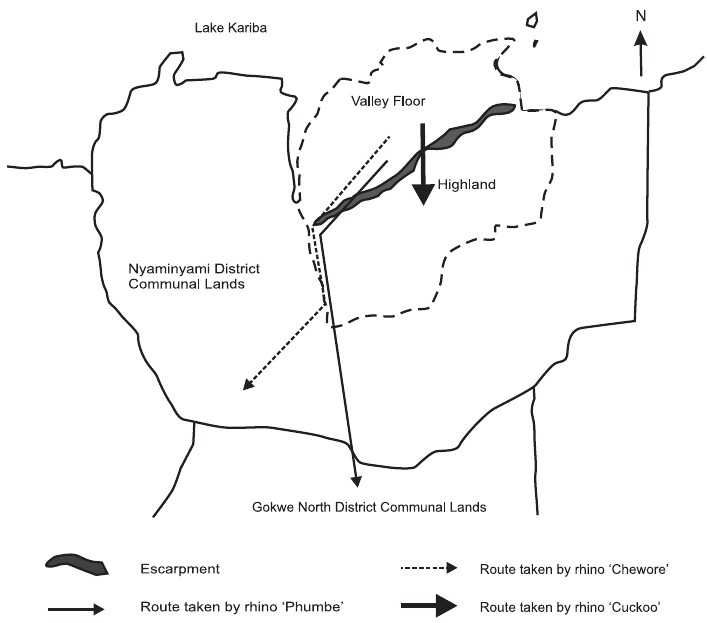
Fig. 2. Map showing movements of hand-raised rhino outside Matusadona National